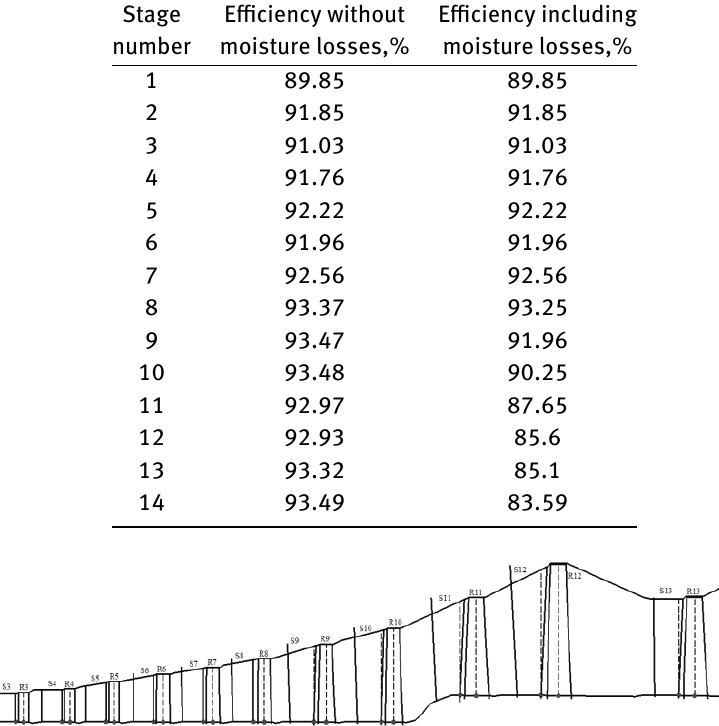
Figure 21. Meridional section of the flow part of the T-125/150-12,8 CMP turbine Figure 21: Meridional section of the flow part of the T-125/150-12,8 CMP turbine